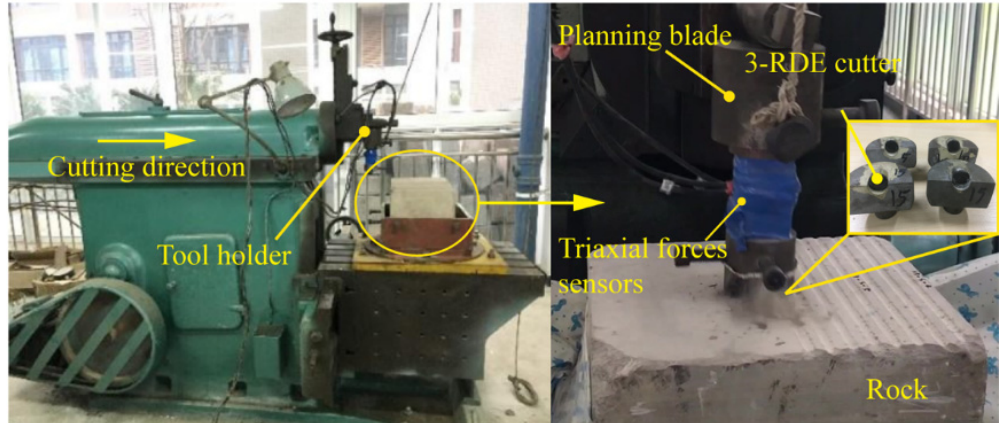
Figure 5. Experimental apparatus.